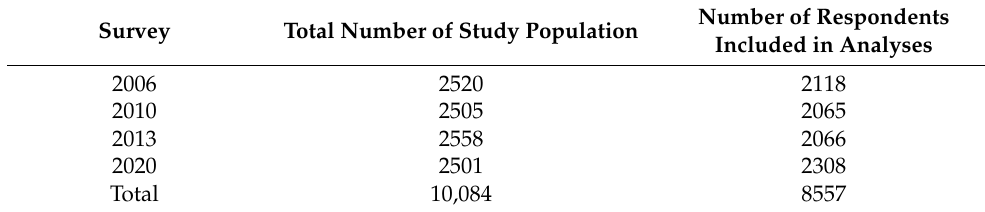
Table 1. Description of the Work conditions and risks in Latvia study sample.